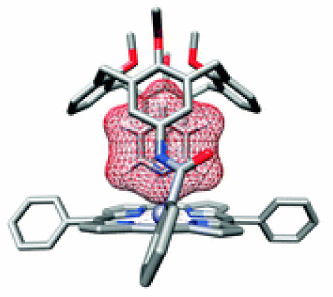
Figure 2. Structure of the 7-Py complex determined by the molecular mechanics methods using the MMFF force field of the MacroModel (V6.5) software package on the SGI O2 workstation [56]. Table 3. Stability constants, K a (M − 1 ), and energies of porphyrinate 7 binding of the